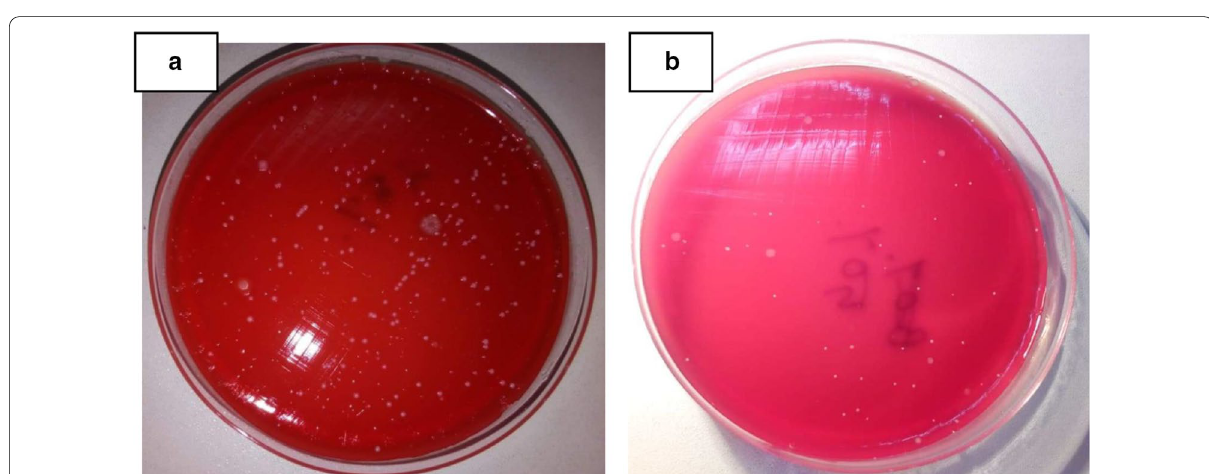
Fig. 4 Number of surviving cells ( S. aureus ) after contact with untreated non-woven fabric sample ( a ) and non-woven fabric sample treated with 50% neem extract solution ( b